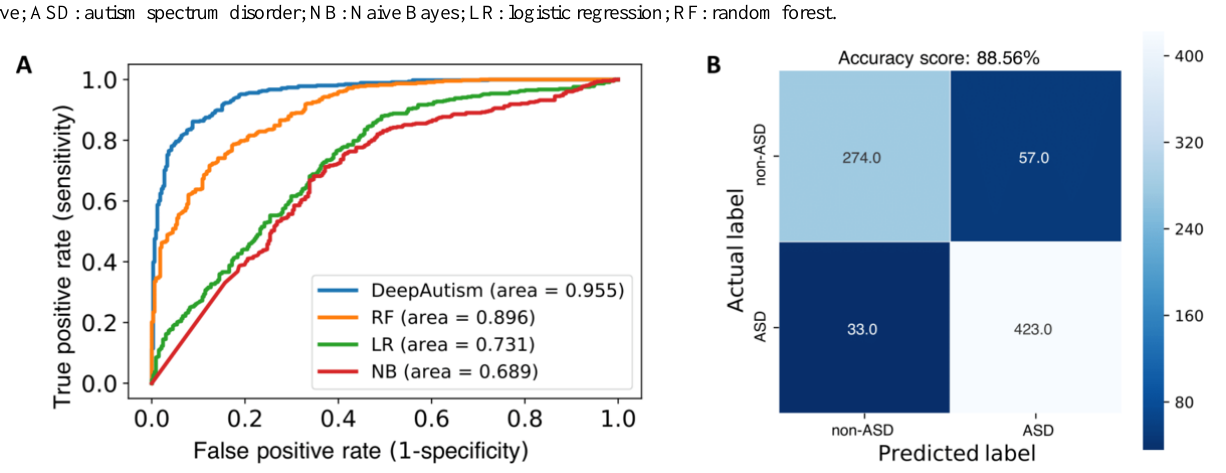
Table 1. Performance of the classifiers with respect to accuracy, sensitivity, specificity, F1-score, and false discovery rate on test sets. a